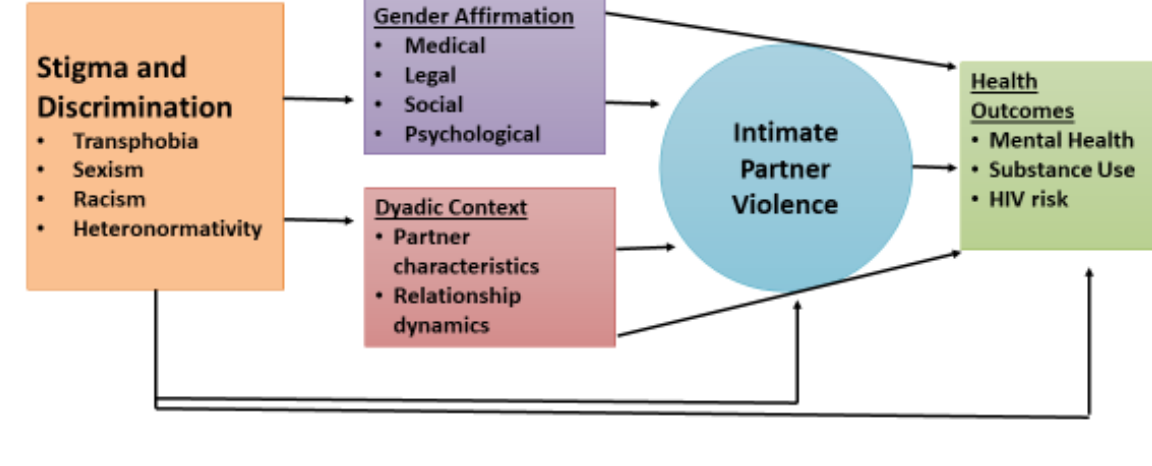
Figure 1. Conceptual model of intimate partner violence among